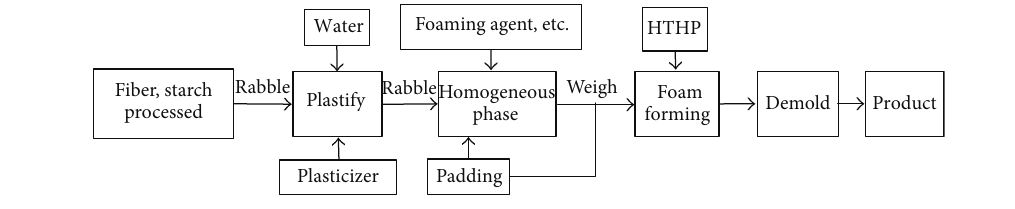
Figure 1: Biomass cushion packaging material forming processes.